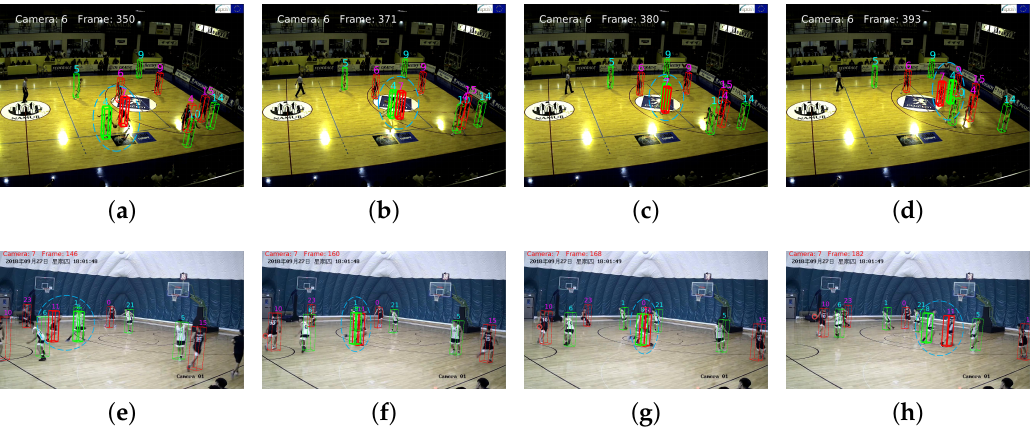
Figure 12. Identity switches can be successfully avoided based on our KSP-AF tracking method in APIDIS and STU datasets. ( a – d ) Part of the tracking effects in APIDIS dataset. Two players annotated with thicker line (yellow player with number 4 and blue one with number 7) come close to each other from frame 350 to 379 and then separate apart at frame 380. After that, they can still remain their own identities at frame 393, which is impossible when the original KSP approach is applied; ( e – h ) the same effectiveness of our KSP-AF method when it is applied in STU